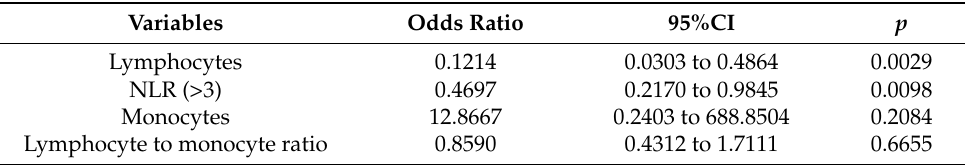
Table 3. The final multivariable logistic model.